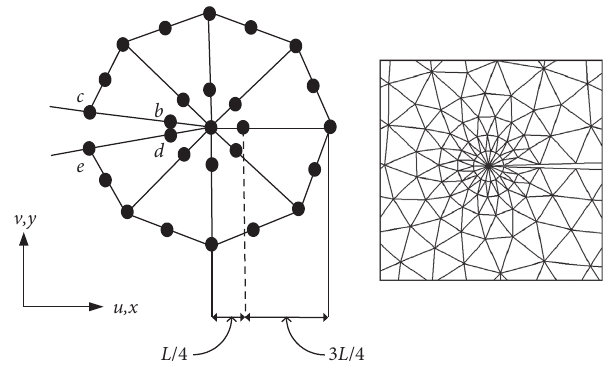
Figure 2: A typical arrangement of the natural triangle quarter-point elements around a crack tip.